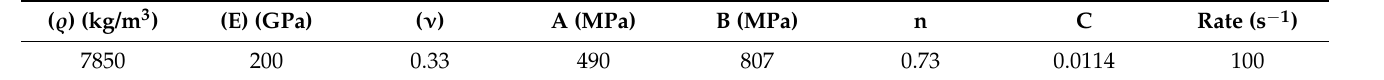
Table 2. Elastoplastic properties of reinforced steel with Weldox 460 E grade.